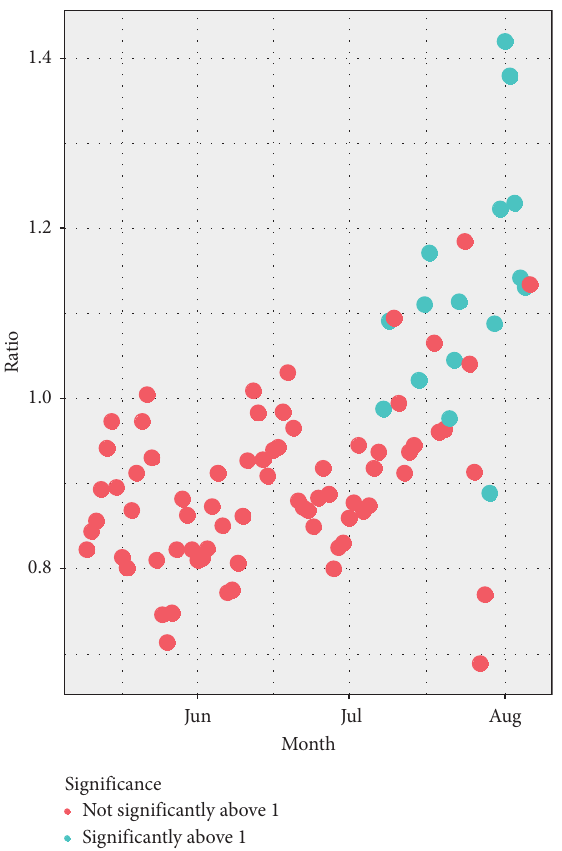
Figure 4: Reproduction ratios and